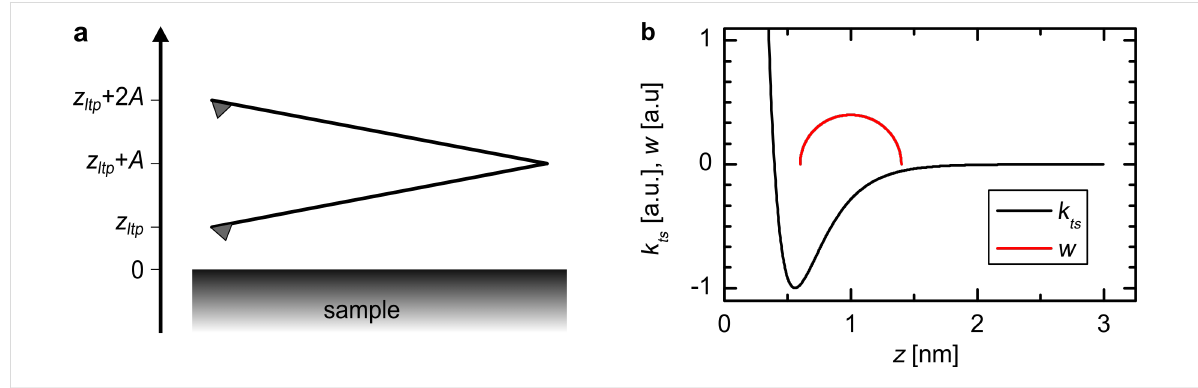
Figure 1: (a) Definition of the z -axis: The cantilever oscillates with a constant amplitude A . The lower turnaround point is denoted with z ltp and the center of the oscillation is at z ltp + A . (b) The frequency shift can be calculated as a convolution of the force gradient k ts with a semicircular weight function w